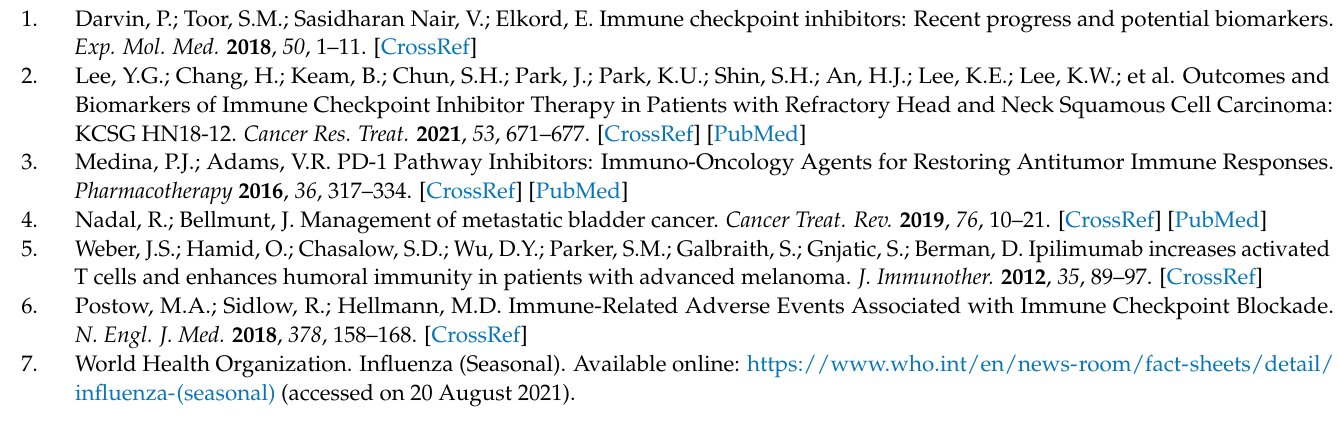
searched; Table S2: Risk of bias within studies assessed with the New-Castle Ottawa Scale; Table S3: Frequency of reported immune related adverse events in vaccinated and unvaccinated patients; Figure S1: Funnel plot for primary outcome; Table S4: Summary of findings